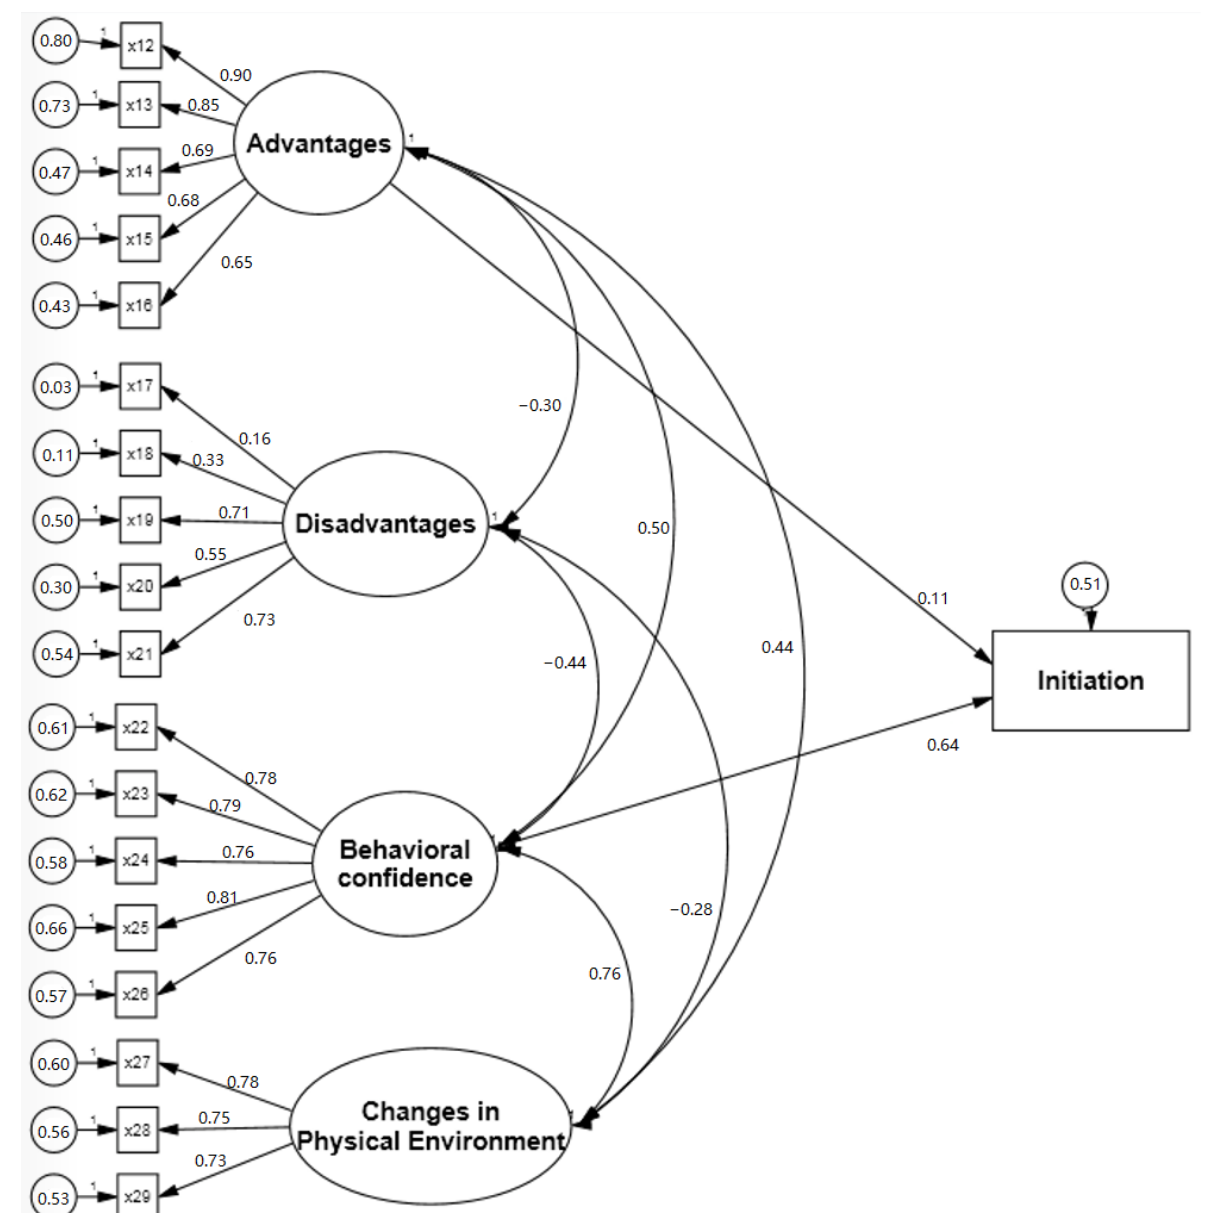
Figure 4. Structural model of initiating flossing.